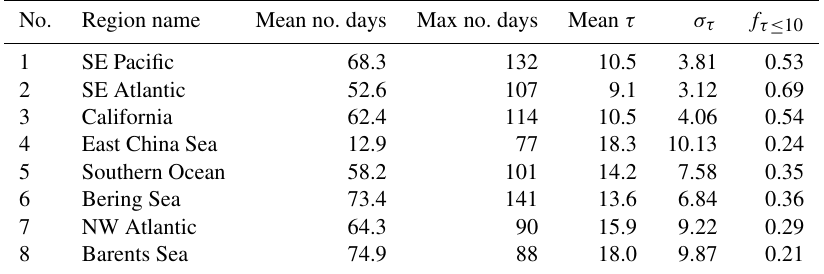
Table 3. Regional statistics for the various marine stratocumulus regions shown in Fig. 3. Shown are the mean and maximum number of days that fulfill the screening criteria in order to be considered as useful N d retrievals; the regional means and standard deviations ( σ ) of the time-averaged optical depths ( τ ) for the screened data set; and the regional mean of the fraction of days for which τ ≤ 10 ( f τ ≤ 10 ), which is calculated using only data from grid points for which the number of days with N d data was ≥ 15. No.